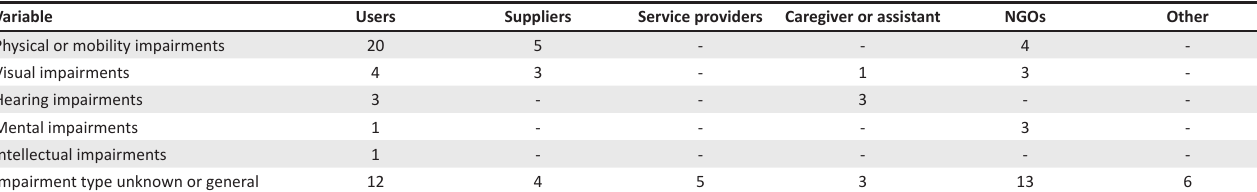
TABLE 2: Background information related to impairments and assistive technology experience of participants.